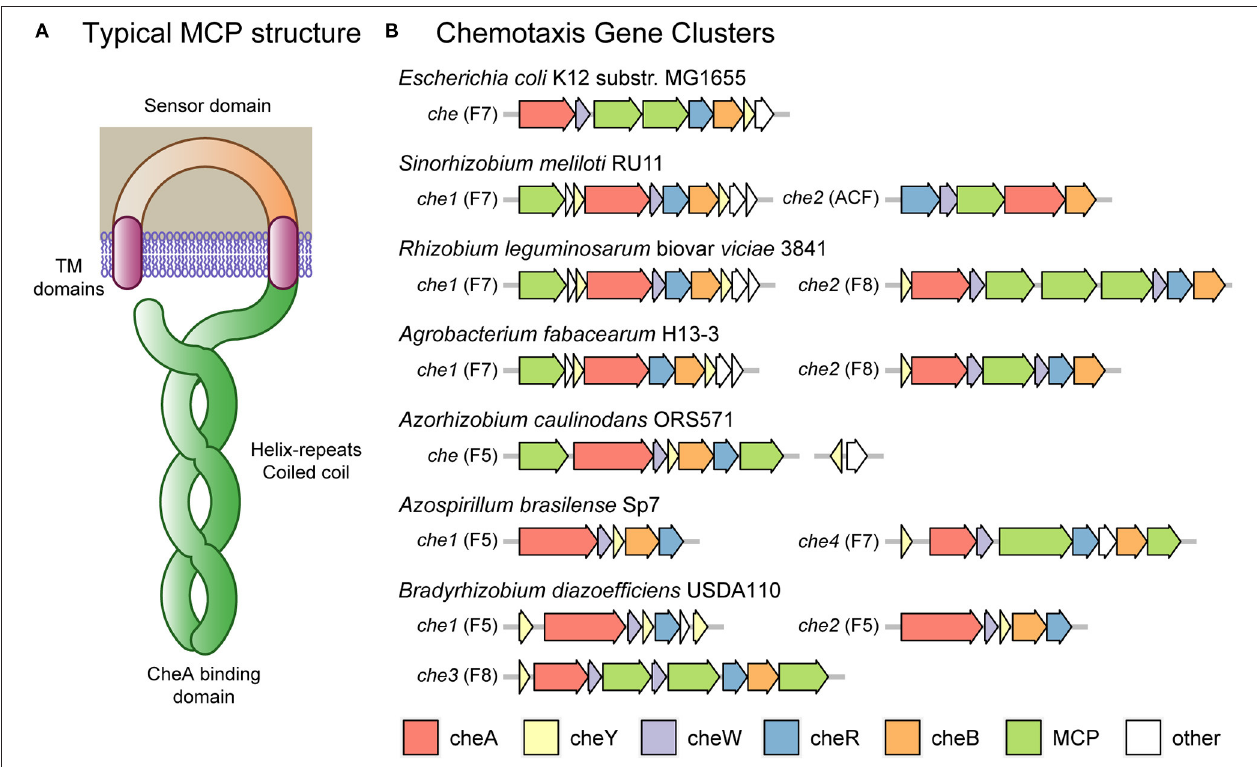
FIGURE 2 | Escherichia coli and rhizobial chemotaxis systems. (A) Typical MCP (methyl-accepting chemotaxis protein) chemoreceptor domain structure including transmembrane domains flanking a periplasmic sensor domain. In the cytoplasm, the receptors form a coiled coil of alpha helices down to the CheA binding domain and returning to the plasma membrane to complete the coiled coil. Methylation and demethylation occur at sites along the coiled coil. The number of helix repeats varies, with some MCPs containing 34, 36, 38 or 40 repeats (classes 34H, 36H, 38H, and 40H, respectively). (B) The chemotaxis clusters of Escherichia coli and various rhizobia. Most clusters consist of the che genes A , Y , W , R , and B . E. coli K12 substr. MG1655 has one cluster of class F7 containing an extra cheZ gene and two MCP genes. Sinorhizobium meliloti RU11 has two clusters: one of class F7 containing extra che genes Y , S , D , and T and one MCP gene; and one of class ACF containing the standard genes except an altered cheA -REC, missing cheY and one MCP gene. Rhizobium leguminosarum biovar viciae 3841 has two clusters: one of class F7 containing extra che genes Y , S , D , and T and one MCP gene; and one of class F8 containing an extra cheW and three MCP genes. Agrobacterium fabacearum H13-3 has two clusters: one of class F7 containing extra che genes Y , S , D , and T and one MCP gene but missing cheW ; and one of class F8 containing an extra cheW and one MCP gene. Azorhizobium caulinodans ORS571 has one cluster of class F5 containing the standard genes and one MCP gene; and 37 kb upstream the che genes Y and Z . Azospirillum brasilense Sp7 has four clusters: one of class F5 containing the standard genes; and one of class F7 containing the standard genes, cheD and two MCP genes. The two clusters not shown have not been linked to chemotaxis. Bradyrhizobium diazoefficiens USDA110 has three clusters: one of class F5 containing two extra cheY genes and one operon reading frame but missing cheB ; one of class F5 containing the standard genes; and one of class F8 containing an extra cheW gene and three MCP